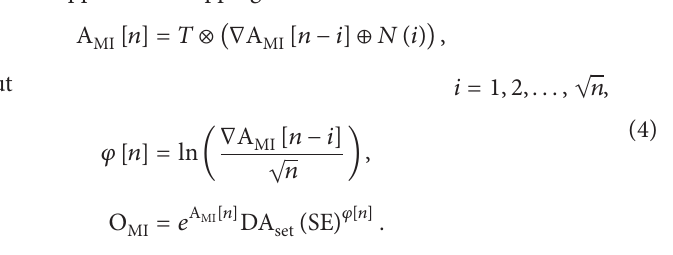
Figure 3: Nonlinear mapping